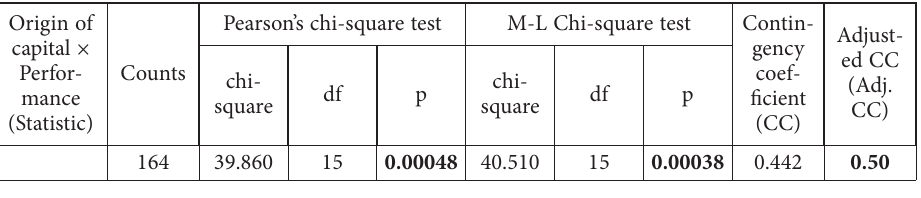
Table 5. Contingency: origin of capital × performance – statistics (source: own)